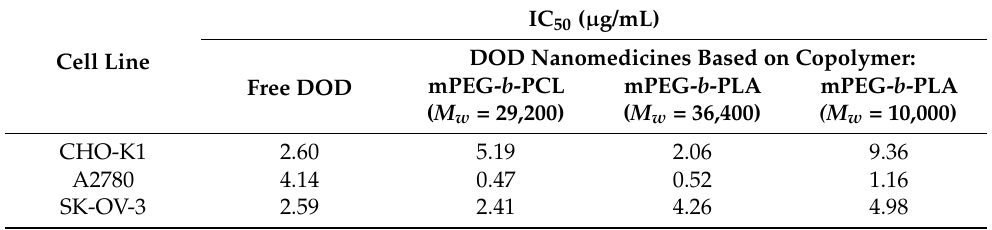
Table 5. IC 50 values determined for free dioxadet and its nanomedicines based on mPEG- b -PLA and mPEG- b -PCL for three different cell